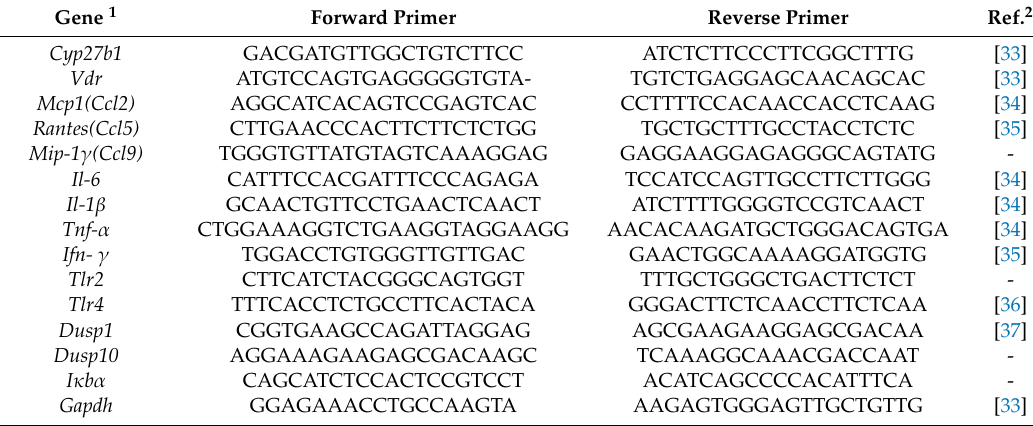
Table 3. Primer sequences used in real-time